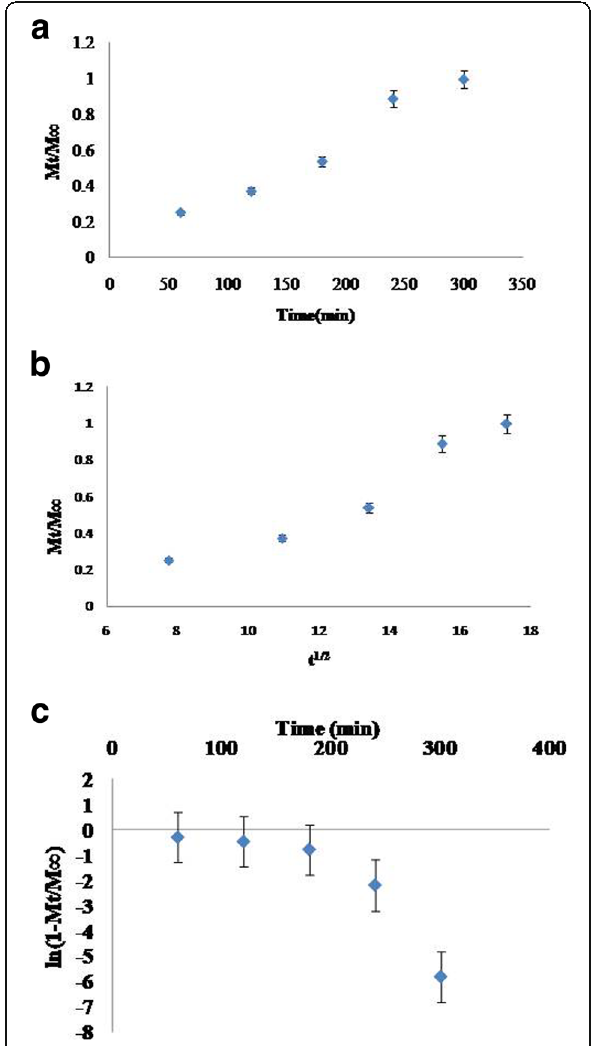
Fig. 3 a The release profile of THP from Ca-ALG NPs as a function of time from Eq. 8. b The release profile of THP from Ca-ALG NP as a function of square root of time. c Plot between ln (1 − M t / M ∞ ) and